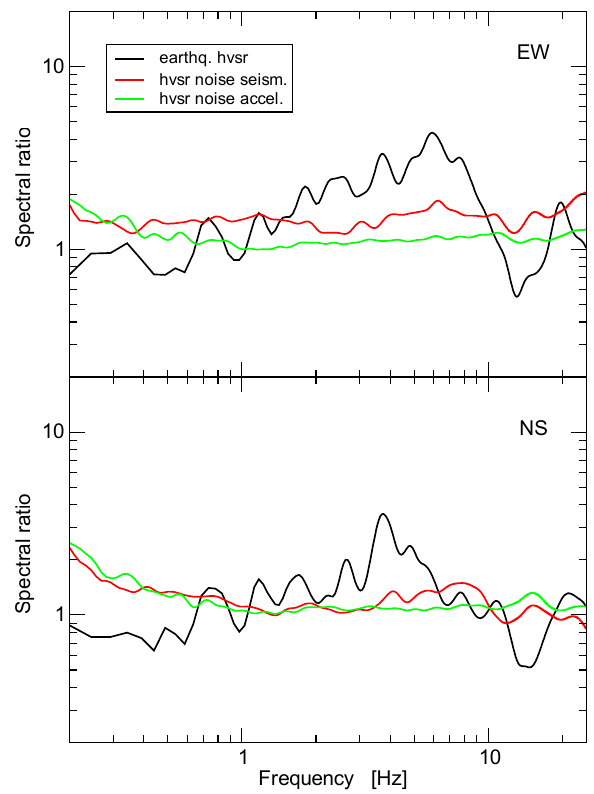
Figure 8. Site amplification estimated at the reference station, CAL. We show average HVSR results computed using earthquake data and ambient noise recorded using a seismograph and an accelerograph. The two diagrams correspond to the two horizontal components.